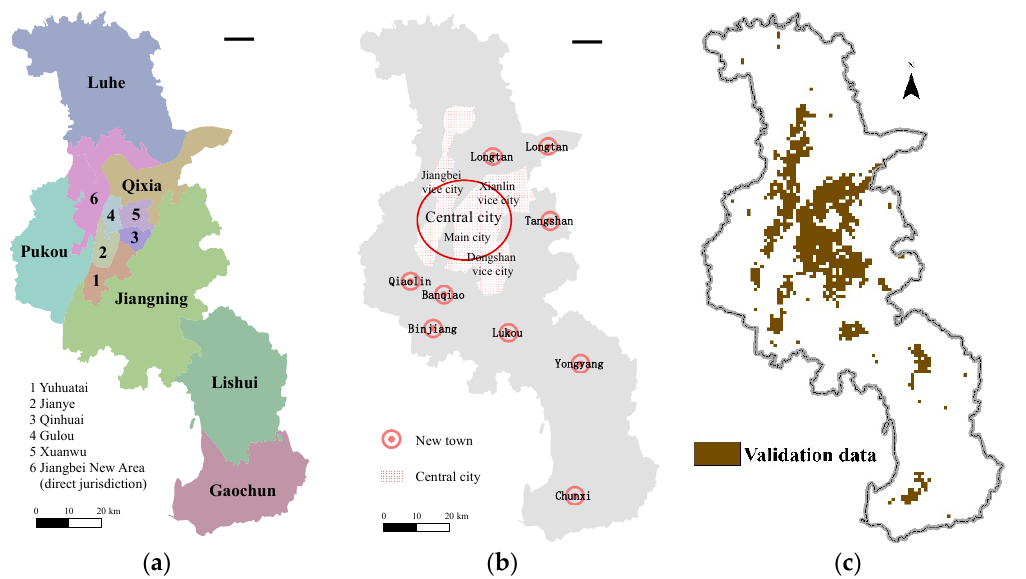
Figure 2. Validation maps of the structure of Nanjing city represented as: ( a ) the zoning mapissued by Jiangsu Provincial Bureau of Surveying Mapping and Geoinformation; ( b ) the urban system map derived from the plan of the Nanjing Jiangbei New District Administrative Committee and the Nanjing Urban Master Plan (2011–2020) issued by Nanjing Municipal Planning and Natural Resources Bureau; ( c ) the built-up area of Nanjing in 2018 from the Resource and Environment Data Cloud